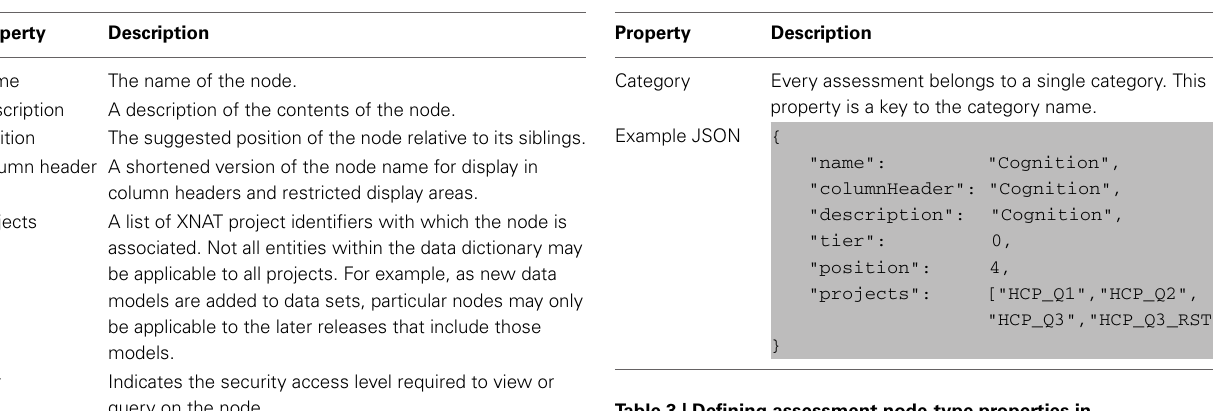
Table 1 | Node attributes.